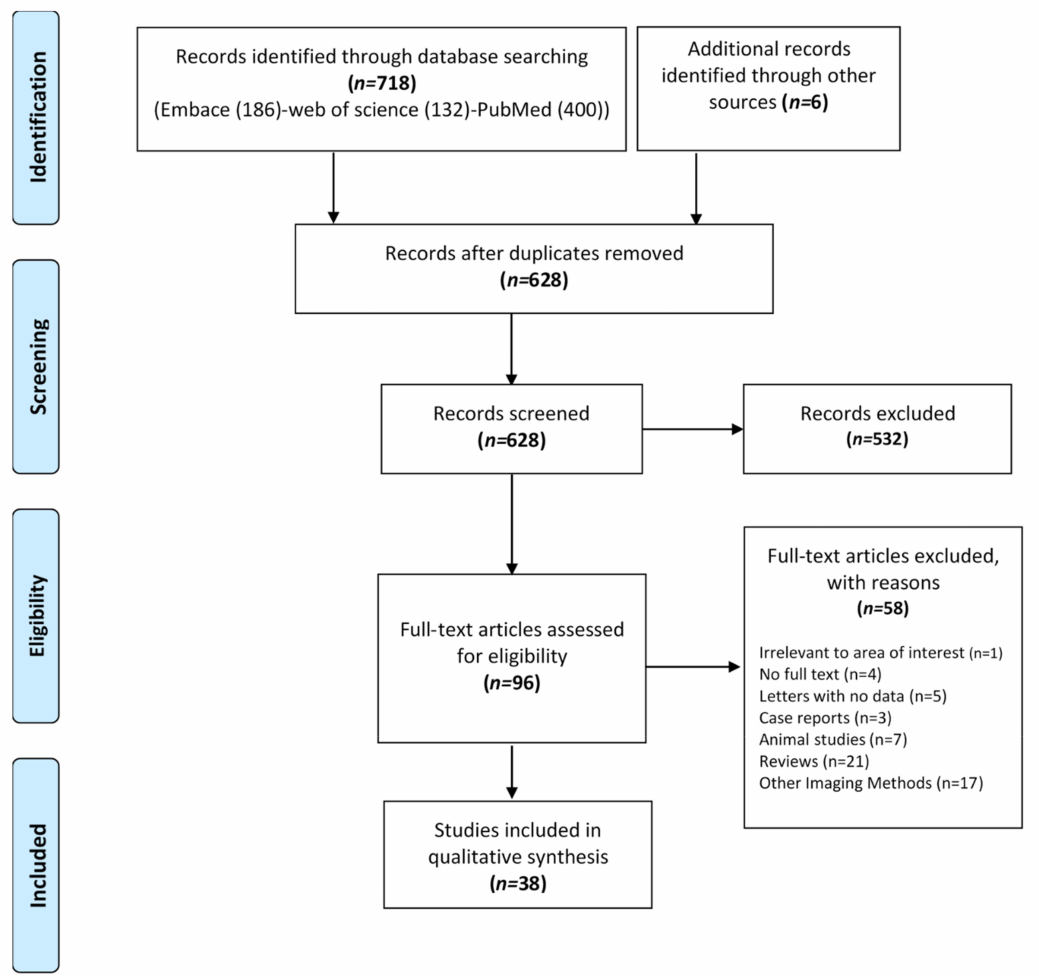
Figure 1. PRISMA flowchart of studies